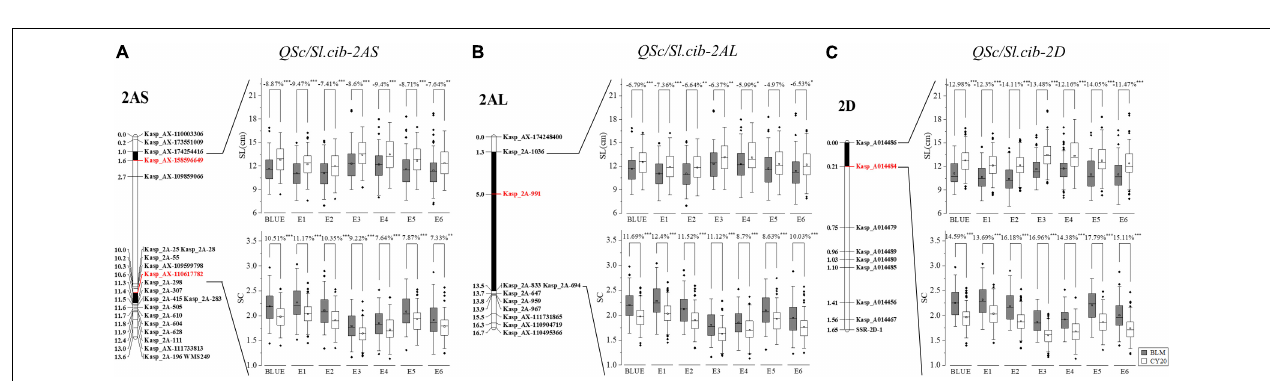
FIGURE 5 | Genetic maps of three major QTL, QSc/Sl.cib-2AS , QSc/Sl.cib-2AL, and QSc/Sl.cib-2D , and their effects on spike compactness (SC) and spike length (SL) in BC20 populations. (A) Integrated genetic map containing the marker Kasp_AX-158596649 and Kasp_AX-110617782 and the effect of QSc/Sl.cib-2AS on SC and SL in the BC20 population. (B) Integrated genetic map containing the marker Kasp_2A-991 and the effect of QSc/Sl.cib-2AL on SC and SL in the BC20 population. (C) Integrated genetic map containing the marker Kasp_A014484 and the effect of QSc/Sl.cib-2D on SC and SL in the BC20 population. BLM and CY20 indicate the lines with the homozygous alleles from BLM and CY20, respectively. *, **, and *** represent significance at P < 0.05, P < 0.01, and P < 0.001, respectively.